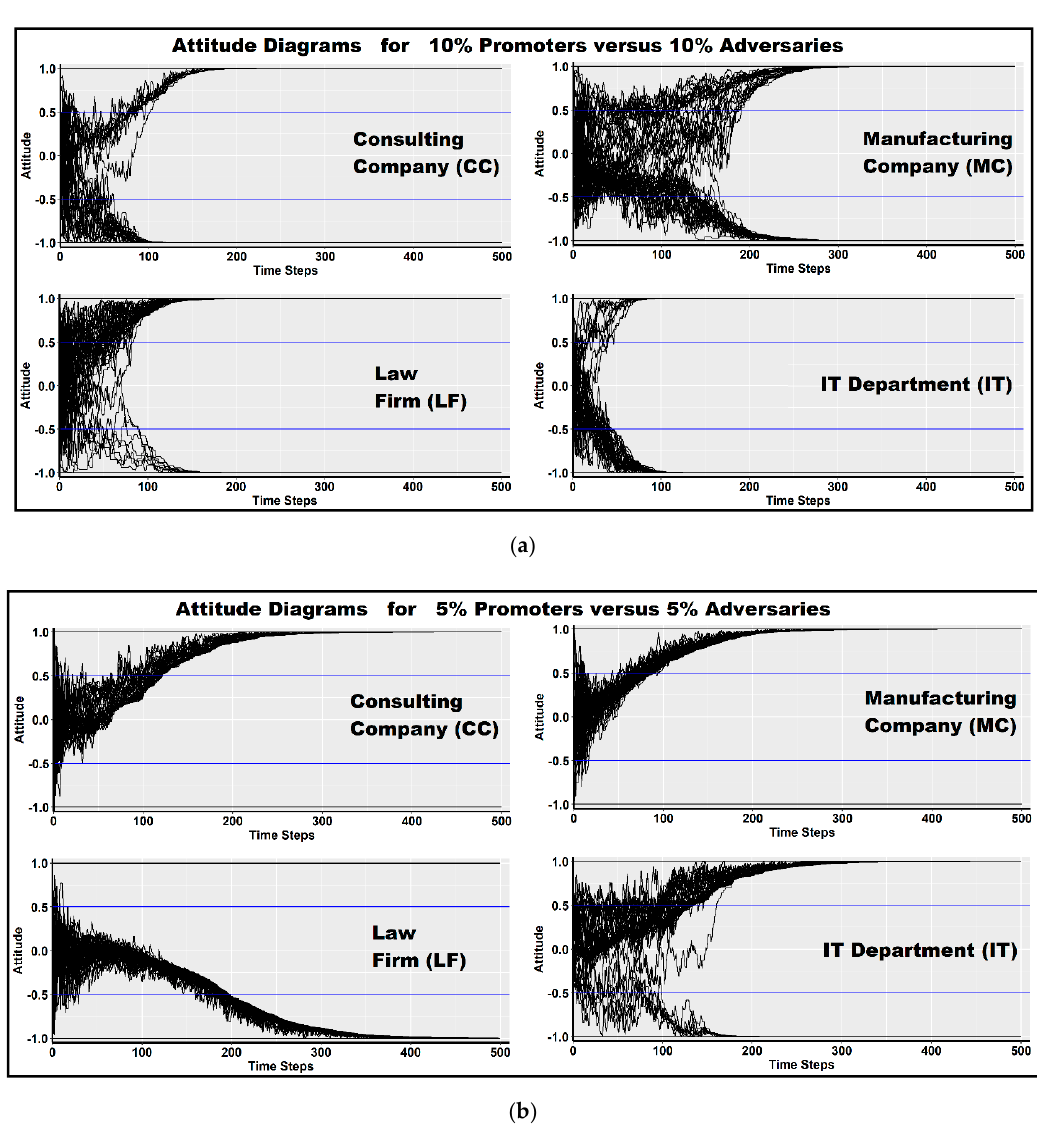
Figure 2. ( a ) Attitude diagrams for the 4 real organizational networks. Both promoters and adversaries have high centrality and the learning rate ℓ is 40% (Table 3). The Supporters, Neutrals, and Opponents are represented in the upper, middle and lower lanes, defined by the accepted deviation δ = 0.5 which is indicated by the two blue horizontal lines. The number of promoters versus adversaries is 10% versus 10%. Polarization emerges for 10% versus 10% or higher 15% versus 15% (see Supplementary Material SM II ). ( b ) Attitude Diagrams for the 4 real organizational networks. Both promoters and adversaries have high centrality and the learning rate ℓ is 40% (Table 3). The Supporters, Neutrals, and Opponents are represented in the upper, middle and lower lanes, defined by the accepted deviation δ = 0.5 which is indicated by the two blue horizontal lines. The number of promoters versus adversaries is 5% versus 5%. In all cases one of the two groups dominates. Promoters dominate completely for the CC and the MC networks and partially for the IT network. Adversaries dominate the LF network. The dominant group appears to emerge randomly.